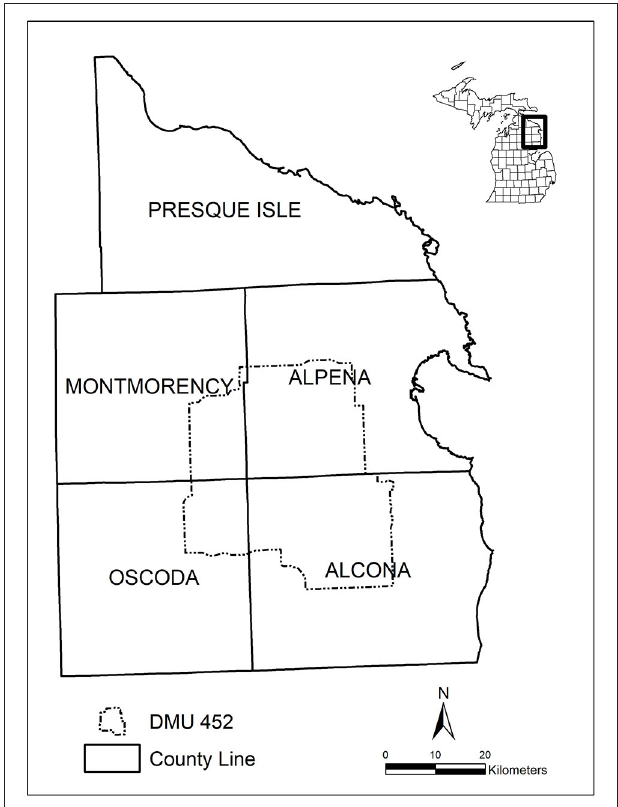
FIGURE 1 | Simulation model study area, Deer Management Unit (DMU) 452, in northeastern Lower Peninsula of Michigan,